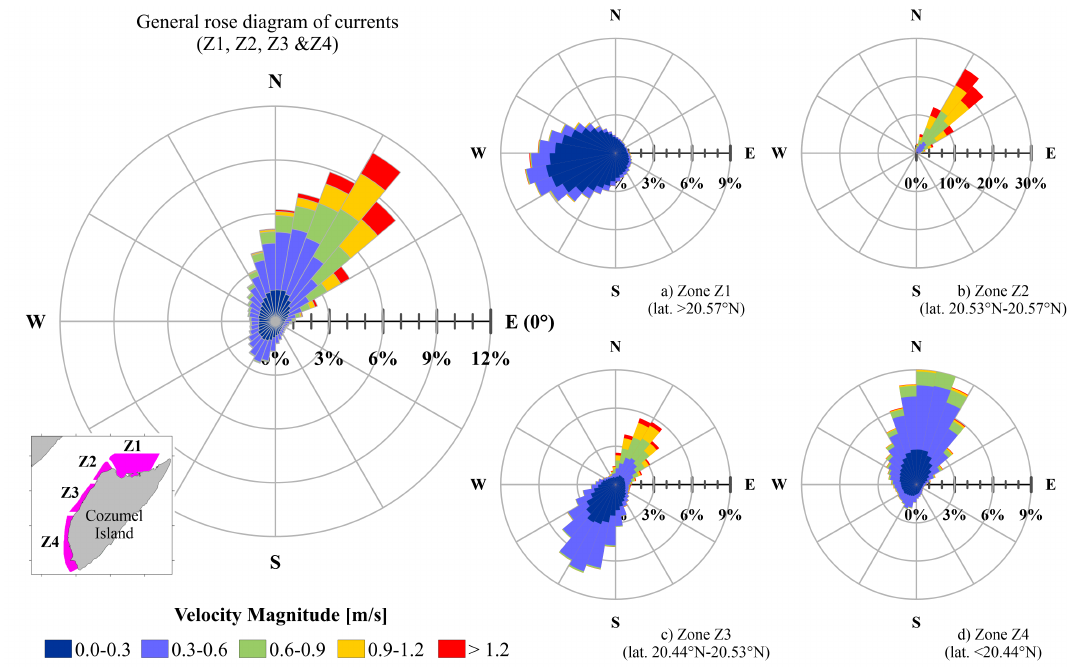
Figure 4. General rose diagram of currents along the east and north shallow waters of the Cozumel Channel ( left ), and for Zones Z1–Z4 featured by different conditions of flow direction and velocity magnitude ( right